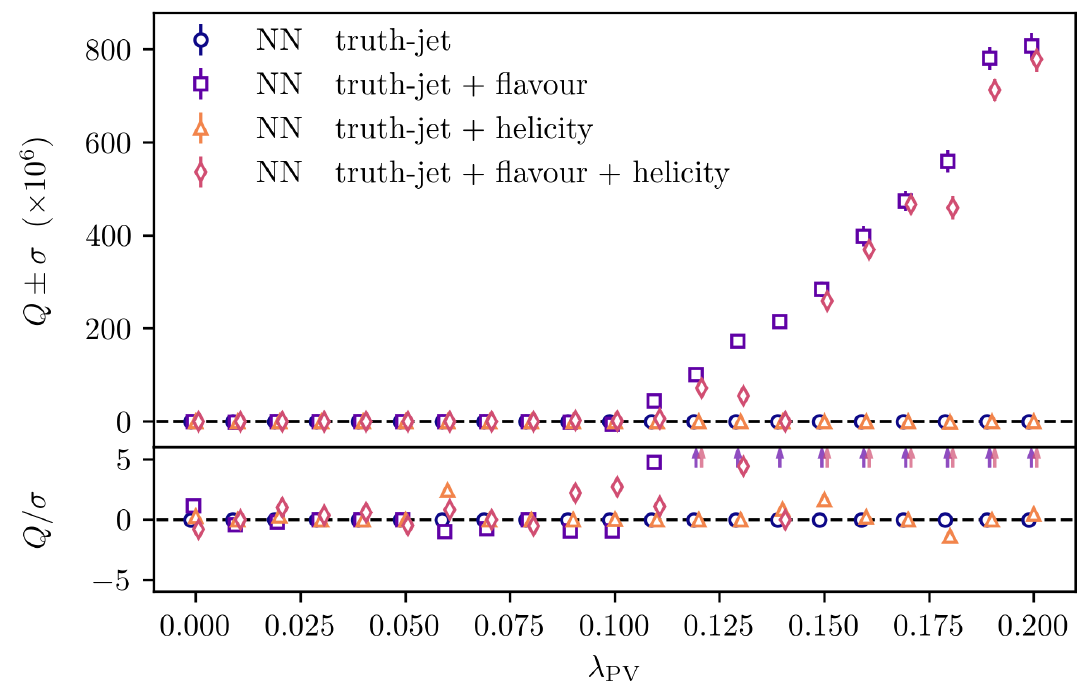
Figure 10 . Test set evaluation score Q for small values of the coupling λ PV , displayed for the NN model applied to truth-jet data with and without the inclusion of parton helicity and flavour information. This figure explores small values of λ to observe the switch-on of sensitivity in the PV leftmost parts of figure 9. All points use approximately two million events in their testing sets. The algorithm has performed poorly for some points; it is not perfect! Markers at each λ point are PV slightly offset to aid